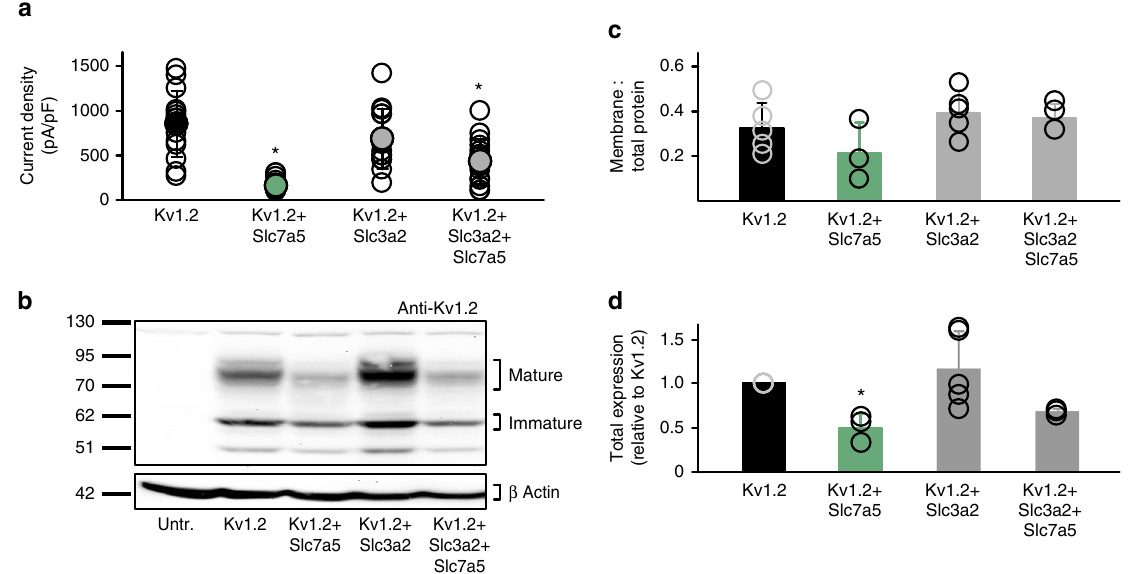
Fig. 2 Slc7a5 alters Kv1.2 expression and current density. a Combinations of Kv1.2, mCherry-Slc7a5, and mEGFP-Slc3a2 were expressed in ltk -mouse fi broblasts. Current density was measured at + 60 mV (pulsed from a holding potential of − 80 mV). Transfection ratios were (with Kv1.2 maintained constant): Kv1.2:Slc7a5 (2:1); Kv1.2:Slc3a2 (1:1); Kv1.2:Slc7a5:Slc3a2 (2:1:2), n = 14 – 19 cells. A non-parametric Kruskal – Wallis ANOVA on ranks test, followed by Dunn ’ s post hoc was used to compare treatments to WT Kv1.2, (* indicates p < 0.05 relative to WT Kv1.2 current density). b Exemplar